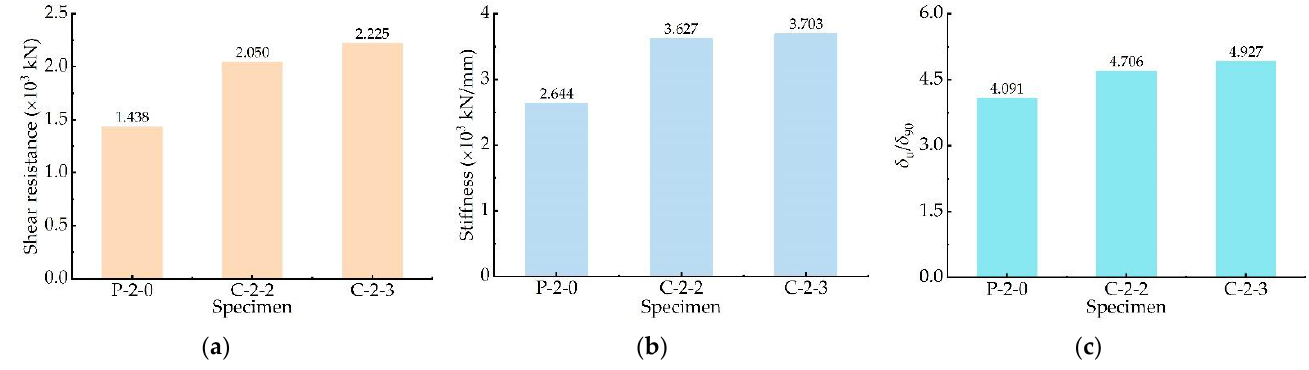
Figure 11. Influence of welded stud number: ( a ) shear resistance; ( b ) shear stiffness; ( c ) ductility.